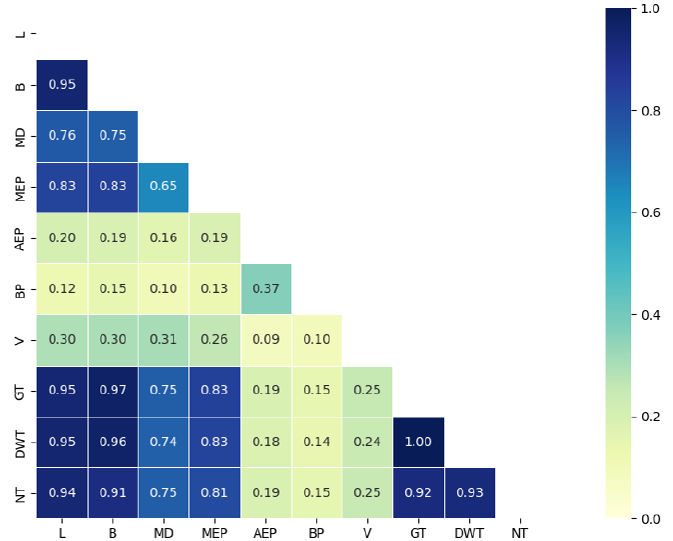
Figure 3. Analysis of R 2 values of the goodness of fit between each design parameter. The correlation coefficient “R” can measure the correlation between two variables, with a correlation close to 1 indicating a strong positive correlation between variables, close to − 1 indicating a strong negative correlation between variables, and close to 0 indicating a slight relationship between variables. The R 2 value is used to measure the fitting degree of linear regression.